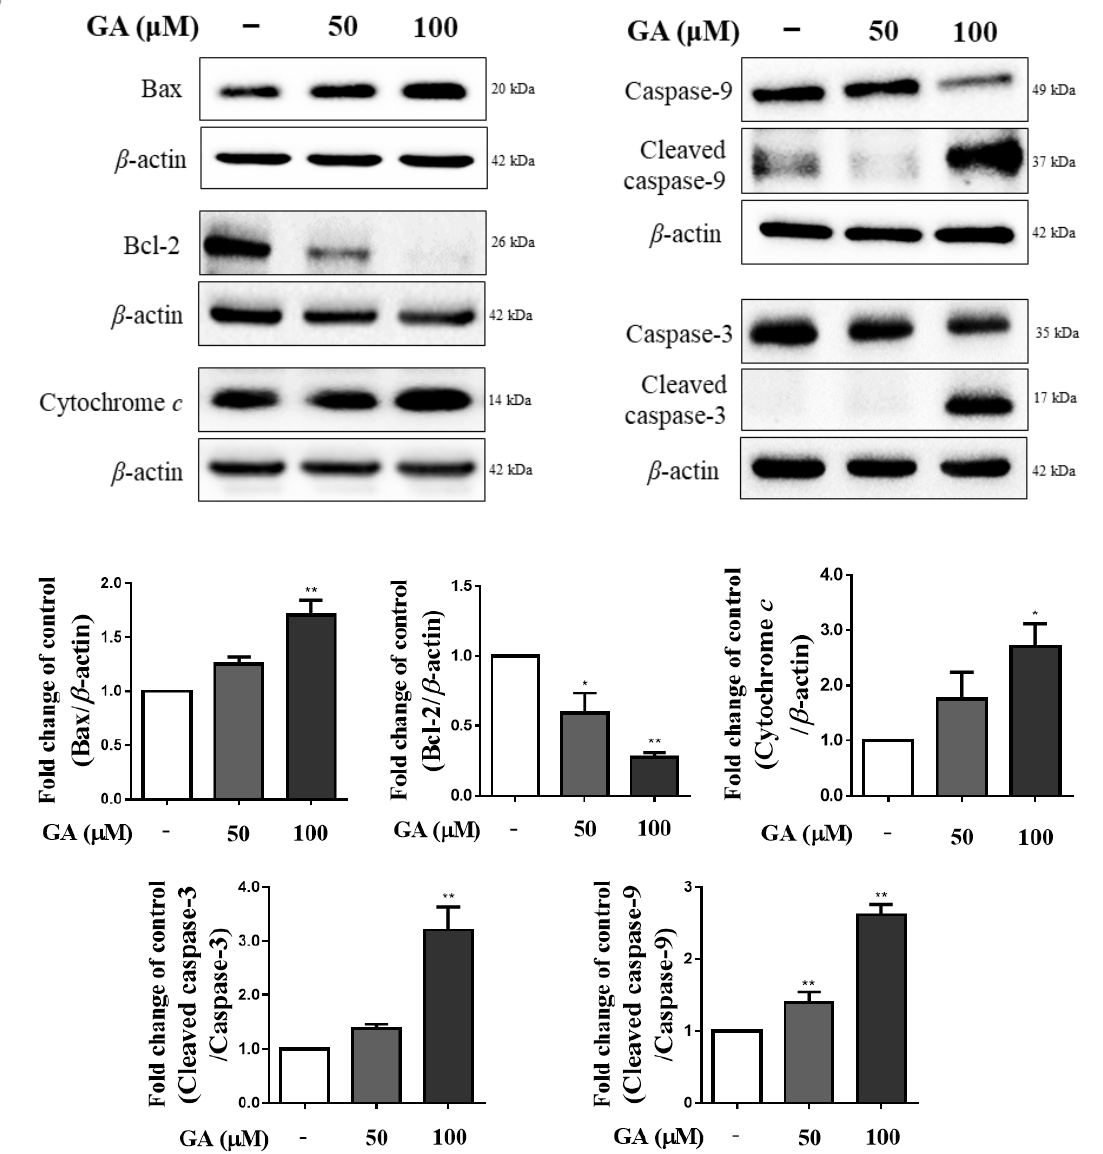
Figure 1. GA induced cytotoxicity and apoptosis-regulating protein expression in mesangial cells. ( A ) The effect of various concentrations of GA (50–200 µ M) in mesangial cells for 24 h. Using MTT assay, the effects of GA on mesangial cell viability were measured. ( B ) Protein expression of Bcl-2, Bax, cytochrome c, caspase-3, and caspase-9 was detected by Western blotting. ( C ) Quantification of Bcl-2, Bax, cytochrome c, caspase-3, and caspase-9 expression. β -actin was used as an internal control. Values for each group are presented as the mean ± SD ( n = 3). * p < 0.05, ** p < 0.01 and *** p < 0.001 vs. untreated group. GA; glycolaldehyde.